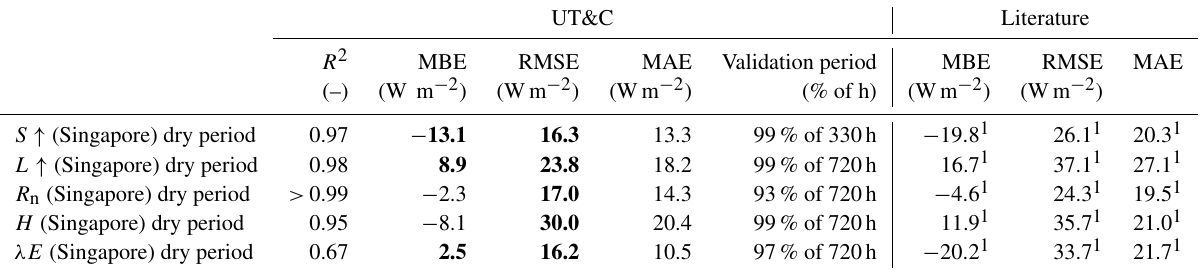
Table 3. Same as Table 2 for the dry period (15 February–16 March 2014) in Telok Kurau, Singapore. Values marked in bold specify an improved model performance of UT&C compared to values reported in